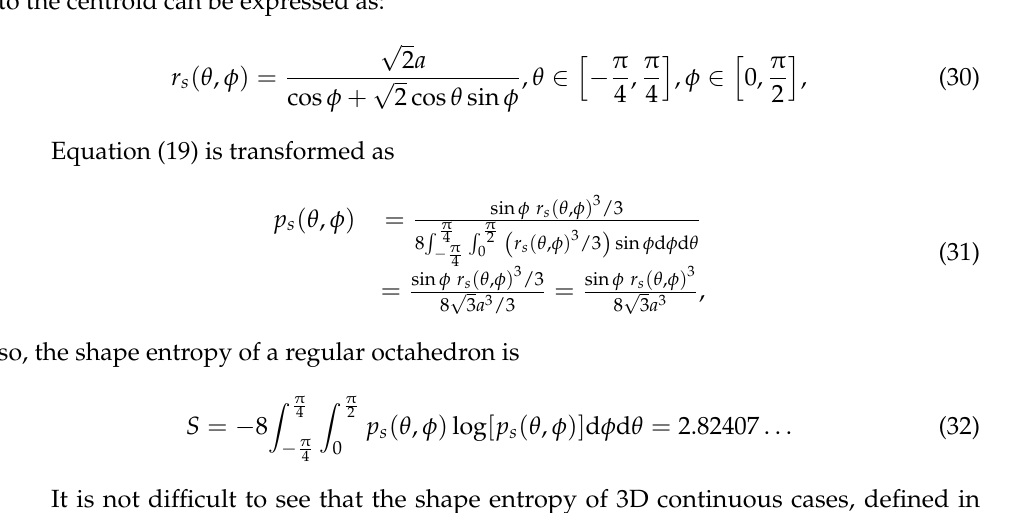
Figure 7. An illustration of a regular hexahedron and the calculation of its shape entropy. For a regular octahedron with an edge length of 2 a , as shown in Figure 8, one-eighth of the octahedron is taken according to symmetry. In this part, using the sine theorem and cosine theorem, the distance from the point on the surface of the original regular octahe-